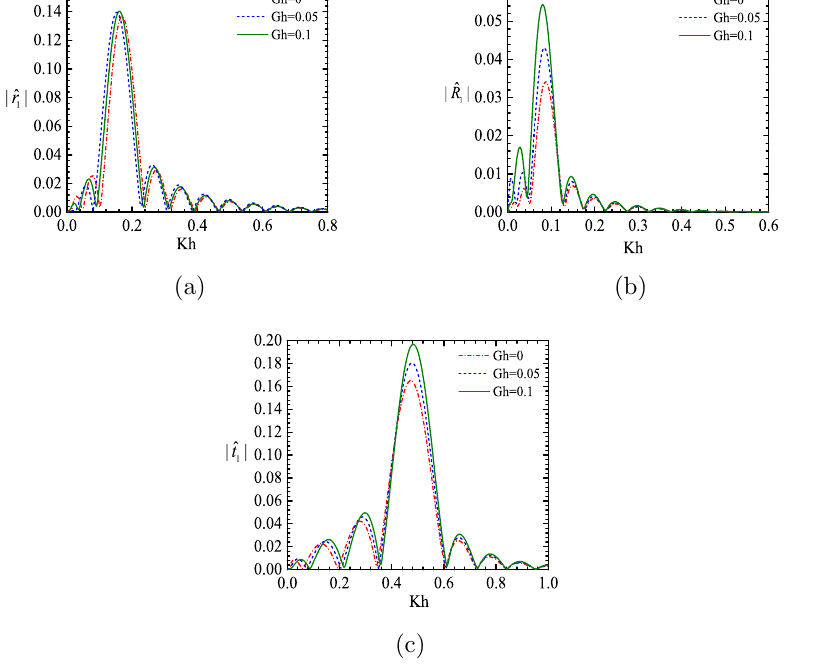
Figure 9. Coefficients due to incident wave of mode λ 2 in (a) | (cid:98) r 1 | ; (b) ρ = 0 . 5, H/h = 2, M/h 2 = 0 . 2, γh = 1, a/h = 0 . 1, m = 5 ,n =